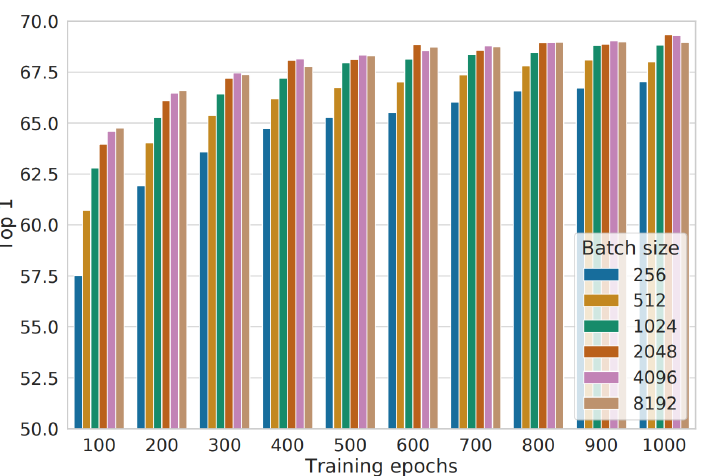
Figure 12. Linear evaluation models (ResNet-50) trained with different batch size and epochs. Each bar represents a single run from scratch